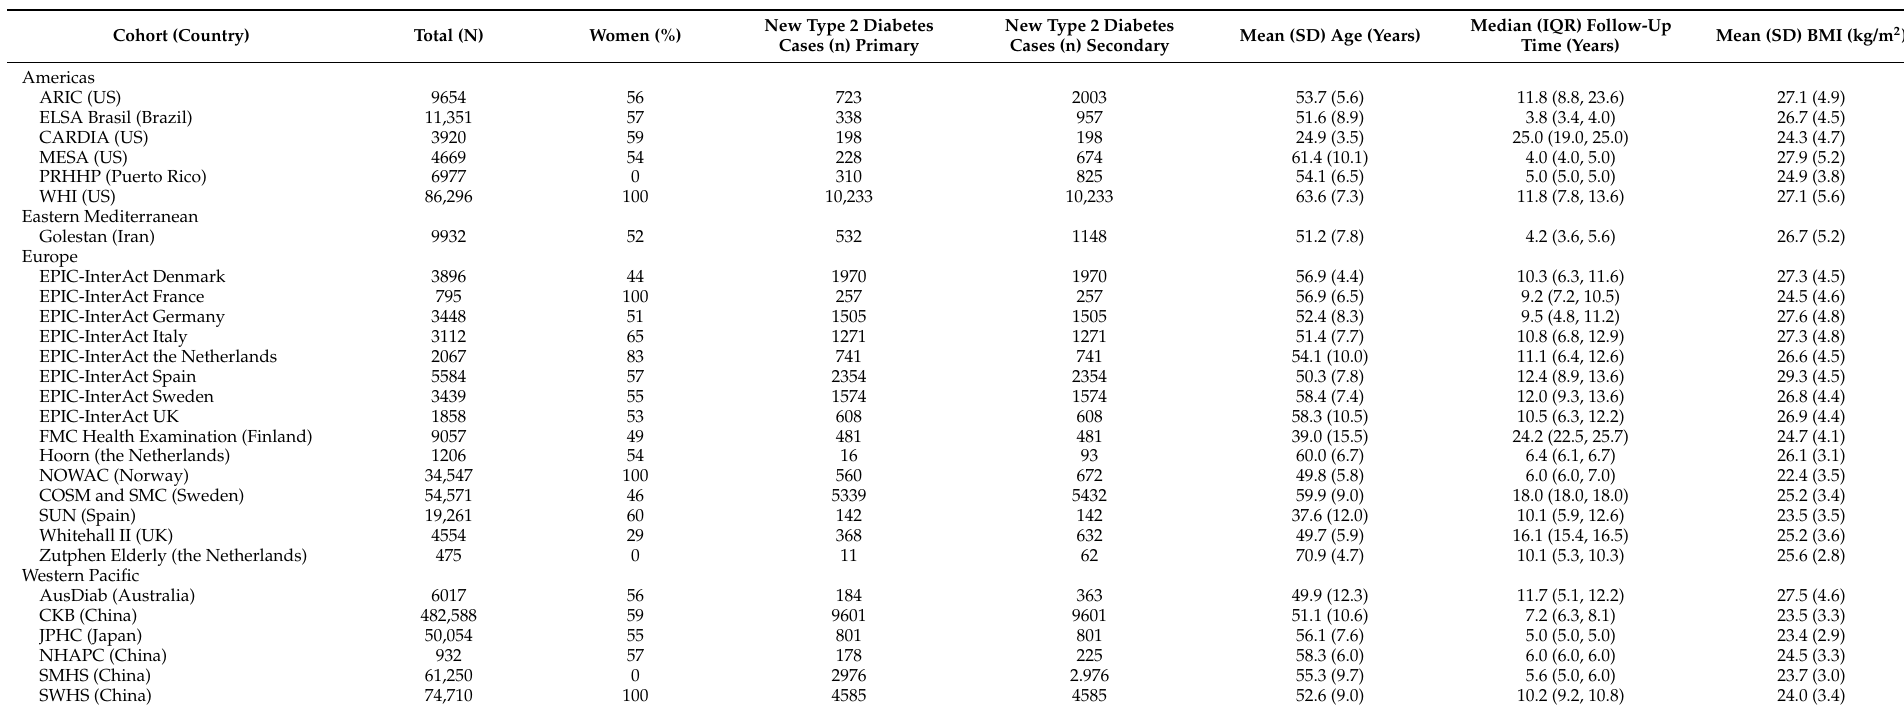
Table 1. Participant characteristics in the cohorts participating in the InterConnect project on the association between fish consumption and type 2 diabetes. Cohort